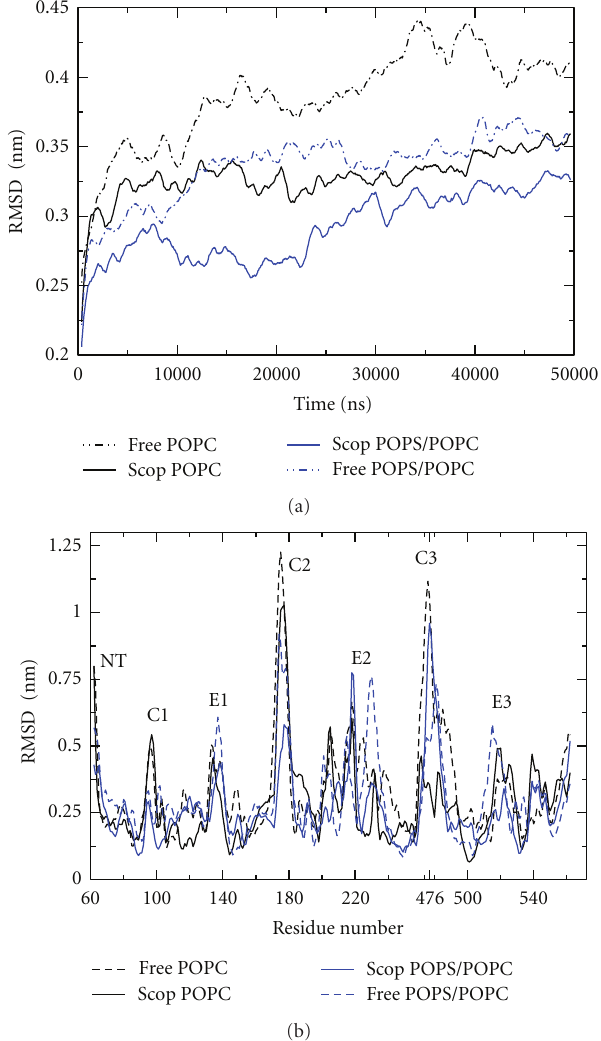
Figure 2: (a) Time evolution of the root mean square deviation (RMSD) of the of the α -carbon atoms of the protein along the di ff erent simulations. (b) Average root mean square deviation (rmsd) of the C α atoms of each residues of the protein through the last 25ns of each simulations computed from an average of the last